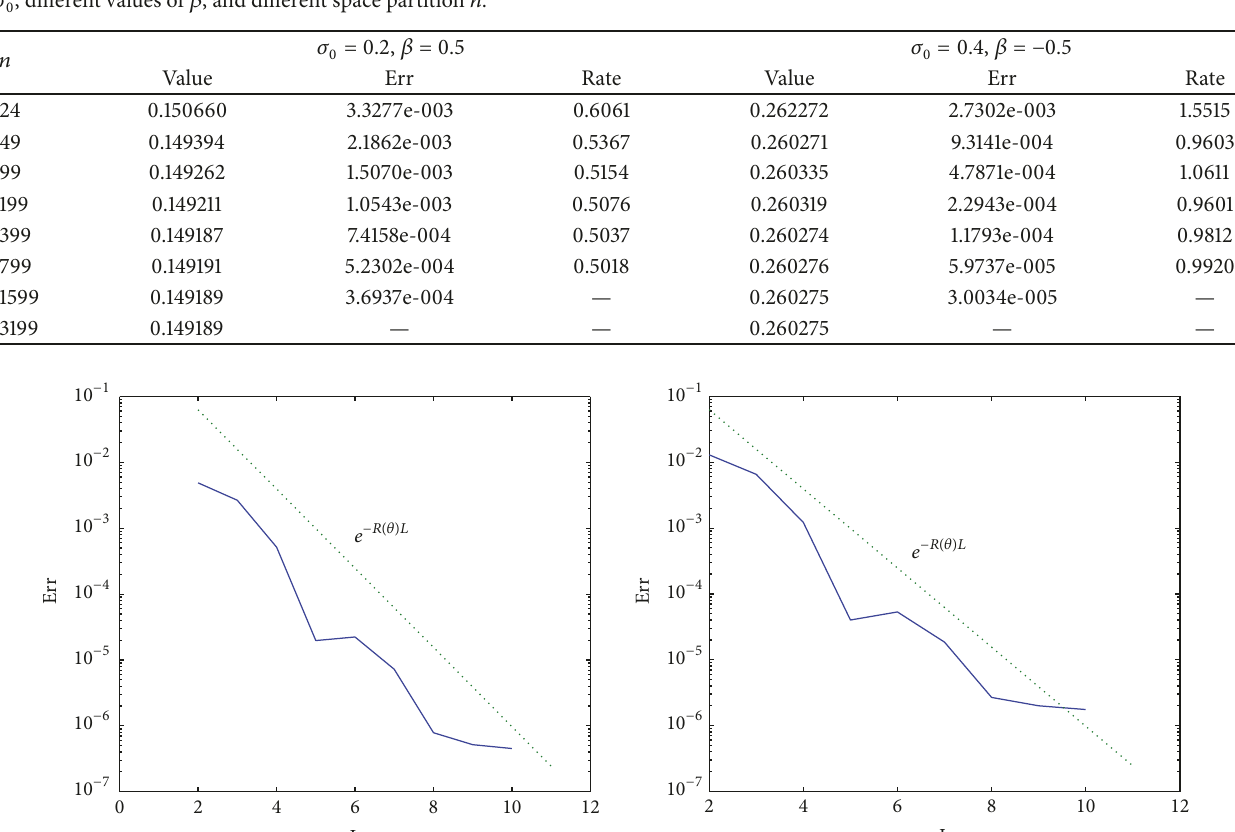
Table 2: Values of American Strangles at time 𝑡 = 0 (i.e., 𝜏 = 𝑇 ) with 𝐾 1 = 1 , 𝐾 2 = 1.5 , 𝑟 = 0.05 , 𝑞 = 0.1 , 𝑆 0 = 1.5 , 𝐿 = 20 , different values of 𝛽 , and different space partition 𝑛 . 𝜎 0 , different values of